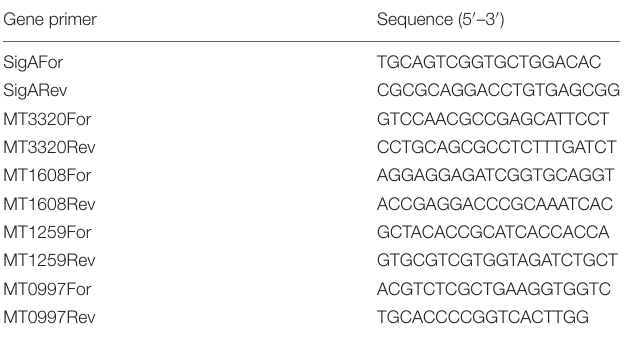
TABLE 1 | Gene-specific primers used for RT-qPCR analysis. Gene primer Sequence (5 (cid:48) –3 (cid:48)